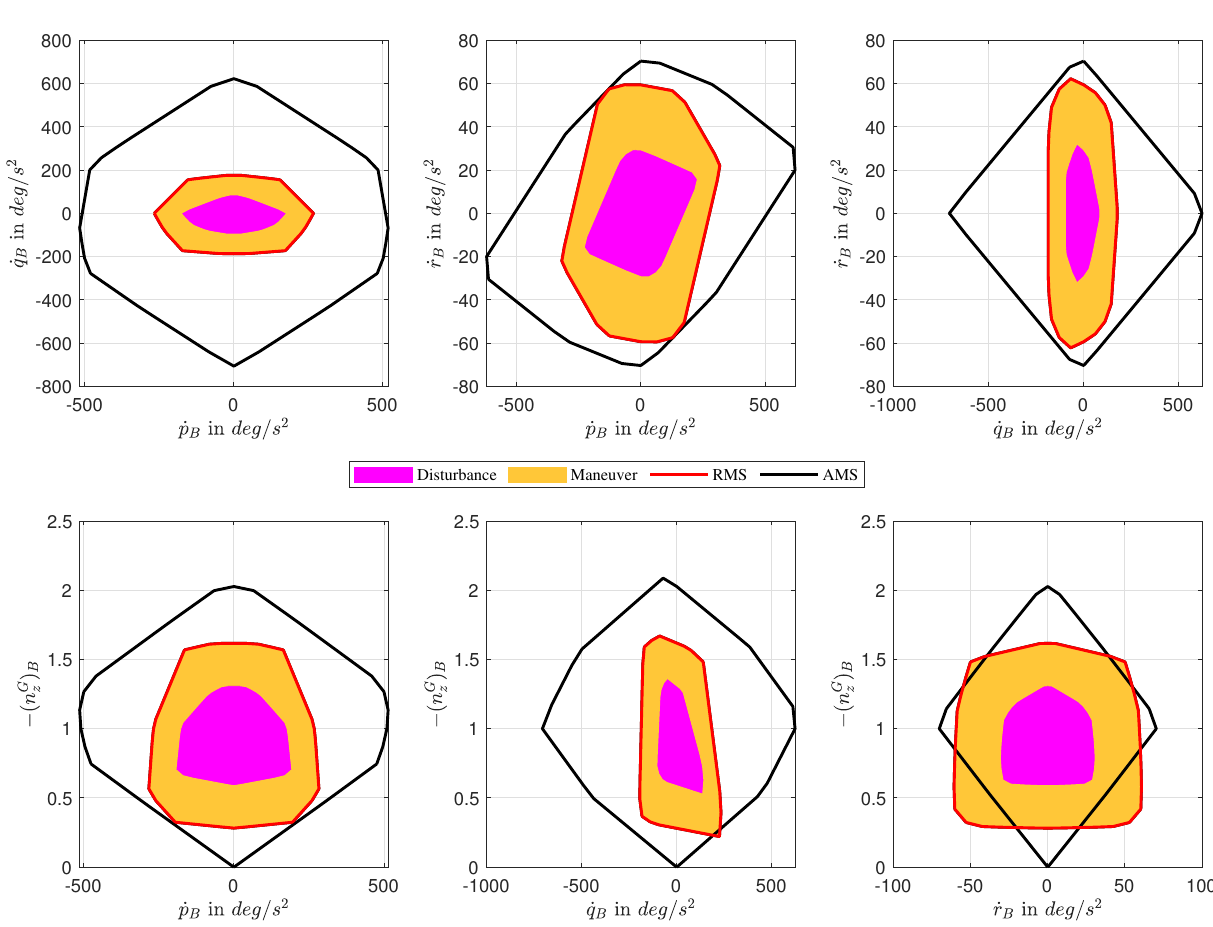
Figure 5. Results of the calculation of attainable moment set (AMS) and required moment set (RMS) hulls. The chosen discretization numbers were ( n u = 5, n v = 5, n w = 5, n Φ = 10, = 12, n = 12, n = 24), the airspeed envelope was defined via n Θ = 10, n β β 2 β 3 1 ( u C , min = − 8 m/s, v C , min = − 8 m/s, w C , min = − 3 m/s, u C , max = 8 m/s, v C , max = 8 m/s, w C , max = 3 m/s,), the maneuver attitude deviations were ( Φ min = − 20 deg, Φ max = 20 deg, Θ